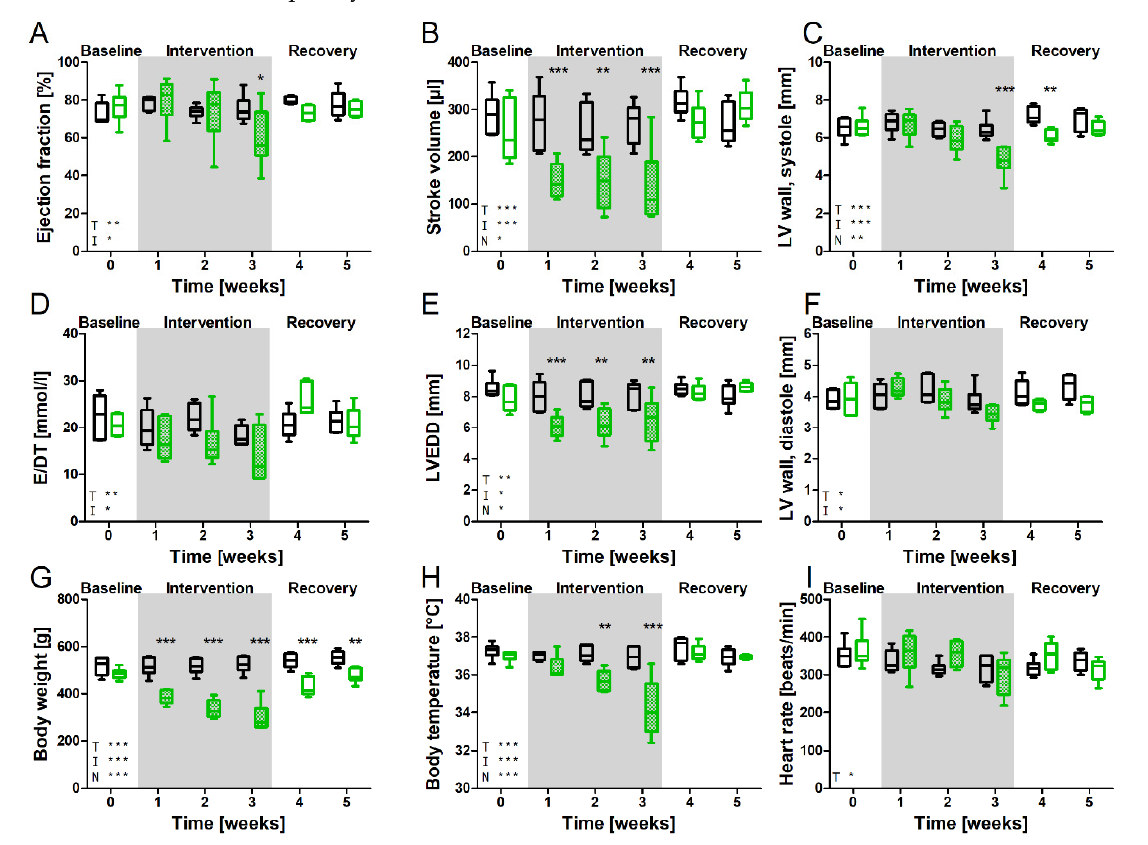
Figure 3. Parameters of left ventricular (LV) cardiac morphology, body weight, body temperature, and heart rate at baseline, throughout NVP-AEW541/vehicle treatment, and during recovery. Ejection fraction ( A ), stroke volume ( B ), systolic ( C ) and diastolic ( F ) LV wall thickness, time velocity index of E-wave (E/DT) ( D ), LV end-diastolic diameter (LVEDD) ( E ), body weight ( G ), body temperature ( H ) and heart rate ( I ). Black boxes indicate controls, n = 6; green boxes indicate NVP-AEW541-treated animals, n = 6. Data are mean ± min/max. Significant differences between treated and control animals (2-way ANOVA analysis), * p < 0.05; ** p < 0.01; *** p < 0.001. N indicates overall differences of NVP-AEW541, T indicates overall differences over time, and I indicates differences based on interaction between treatment and time. NVP-AEW541 affected cardiac protein expression and phosphorylation of Ins/IGF-1R and